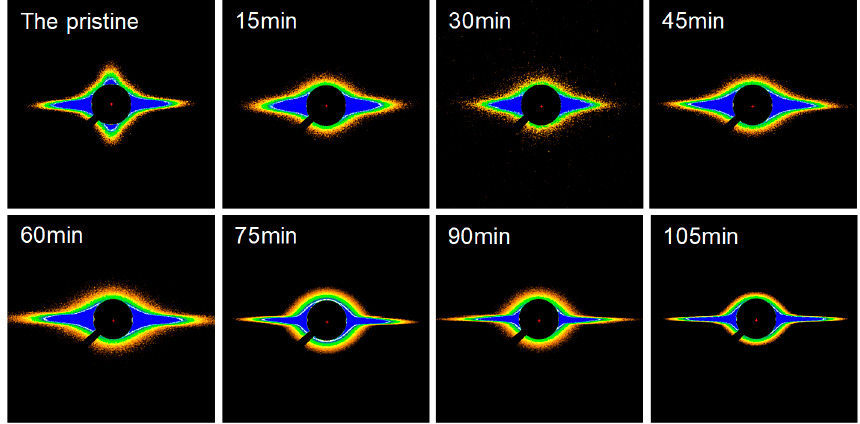
Figure 11. The small angle X-ray scattering patterns of the pristine and treated F-III fibers in Sc-CO 2 .